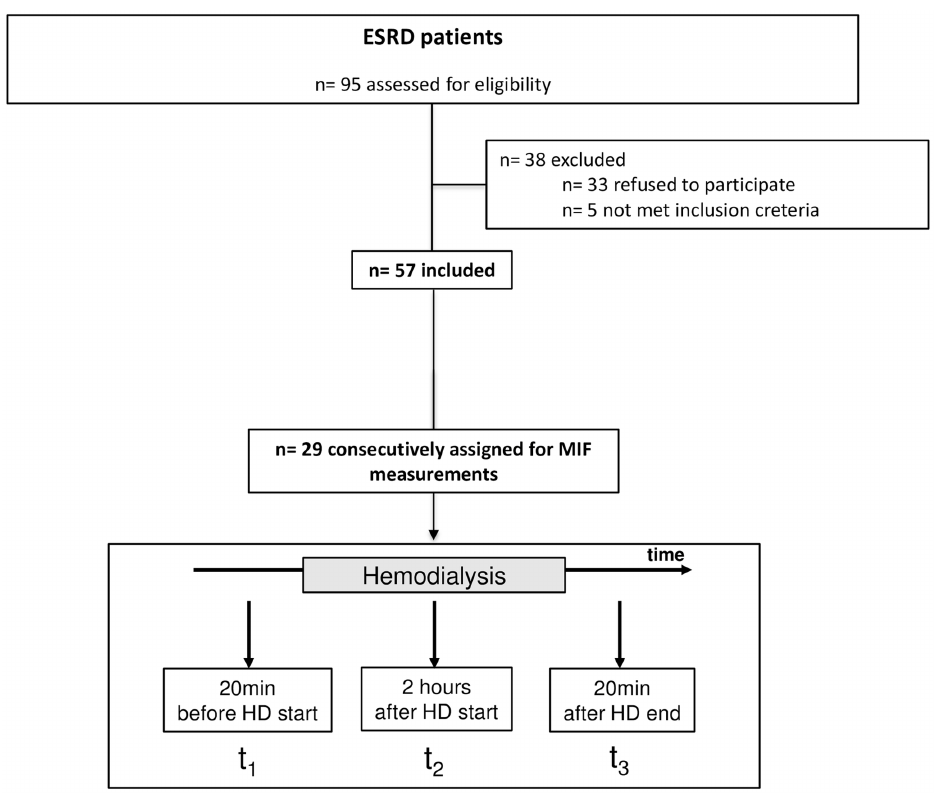
Fig 1. Flowchart of recruited patients. The included ESRD patients represent a random sample of a larger group of patients (n = 57) in which the influence of flavanols on vascular function in ESRD patients is investigated. Of these, n = 29 were consecutively assigned for analysis of MIF plasma level before, during and after hemodialysis (HD). The different time points for blood sample collection were 20 min before start of HD (t 1 ), 2 hours after start of HD (t 2 ) and 20 min after termination of HD (t 3